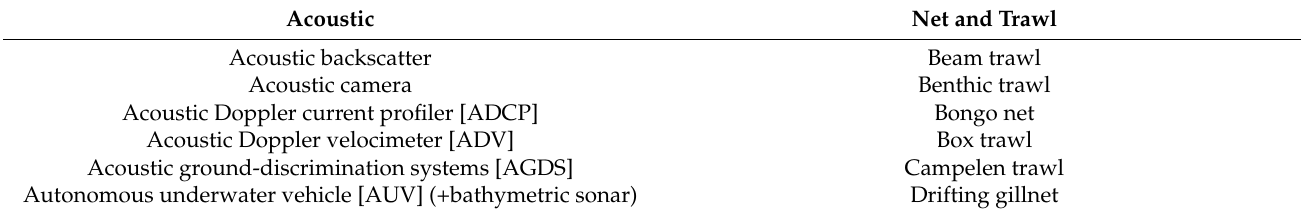
Table 3. Complete list of the sampling/surveying technologies compiled from the literature review and organized in technology classes. Technology acronyms are provided within brackets while secondary technologies are within